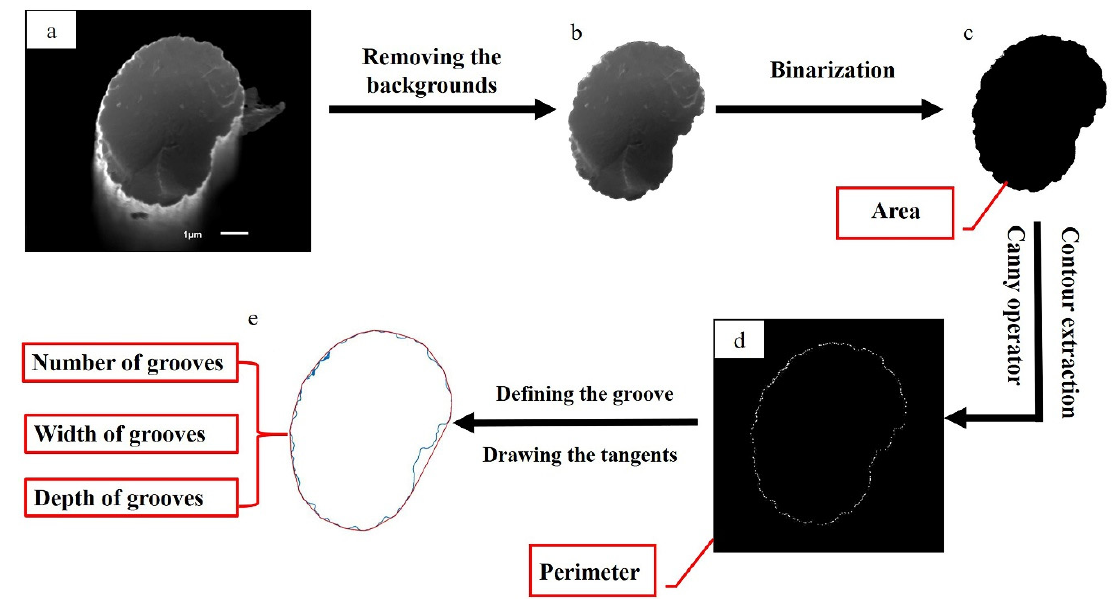
Figure 1. Schematic diagram of quantitative characterization process of CF surface physical structure: ( a ) Original CF cross-section SEM image, ( b ) CF cross-section SEM image without background, ( c ) CF cross-section binary image, ( d ) CF cross-section contour image, ( e ) CF cross-section edge tangent image.